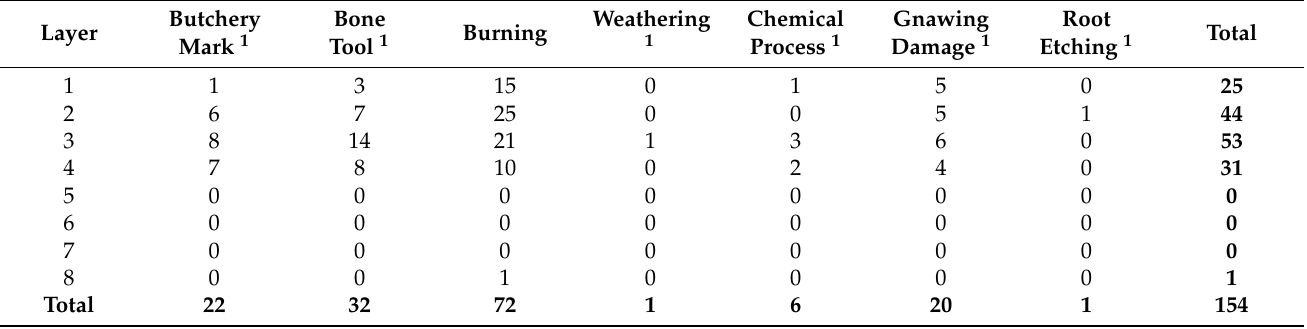
Table 3. Taphonomic evidence in Area 1 of the Ban Rai Rockshelter, in numbers of specimens.